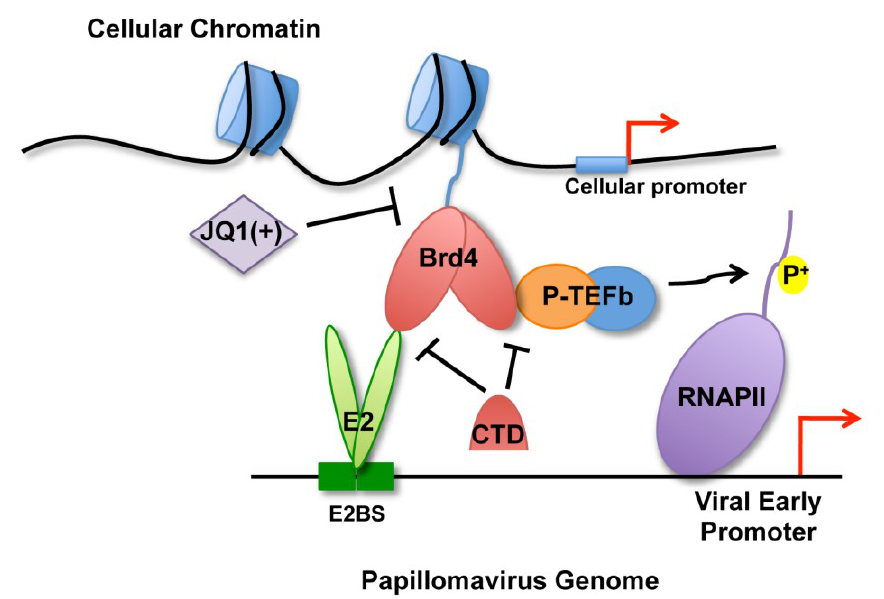
Figure 6. A model of Brd4 functions in E2-mediated viral transcription activation. Papillomavirus E2 protein binds to the E2 binding sites (E2BS) upstream of the early promoter as a dimer. E2 interacts with Brd4 at the C -terminus while the N -terminal Brd4 bromodomains direct E2 and the viral genome to transcriptionally active regions of the cellular genome. Brd4 can form homodimers and also recruit P-TEFb to the viral promoter to phosphorylate the RNA pol II CTD to activate transcription elongation. However, JQ1(+) blocks Brd4 association with cellular chromatin, impeding the recruitment of the viral genomes to transcriptionally active areas of the cellular genome and thereby inhibiting E2-mediated transcription activation of the papillomavirus promoters. The Brd4-CTD can abrogate the E2-Brd4 interaction as well as the Brd4-Cdk9 interaction, thus blocking P-TEFb recruitment to the viral promoter and preventing the activation of transcription elongation by